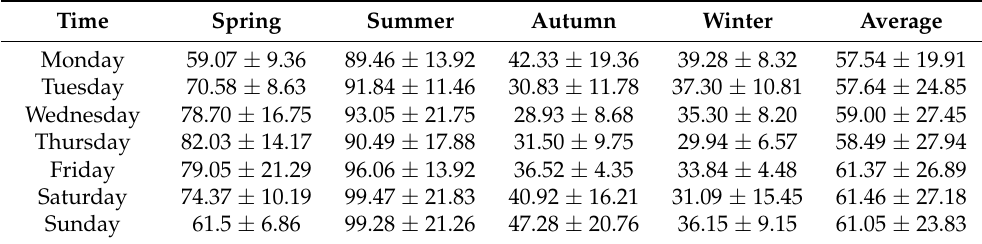
Table 1. Weekly variation of daily mean O 3 concentration ( µ g · m − 3 ). Time Spring